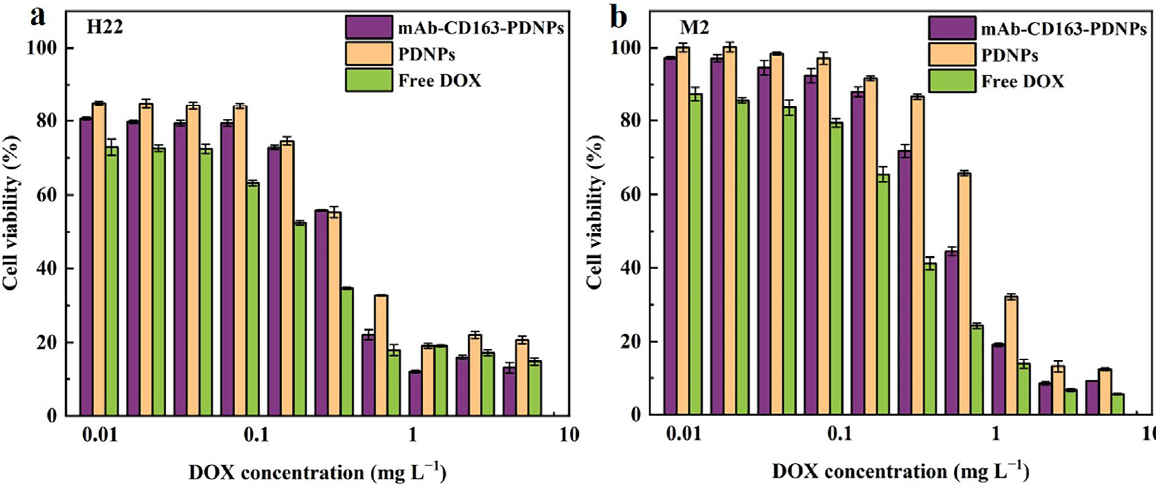
Figure 5. Cell viability of ( a ) H22 cells and ( b ) M2-type macrophages incubated with different doses of free DOX, PDNPs, and mAb-CD163-PDNPs, respectively, for 48 h. Compared with the IC 50 value of mAb-CD163-PDNPs (0.541 mg · L − 1 ) and PDNPs (0.860 mg · L − 1 ) on M2-type macrophages, it was not difficult to find that mAb-CD163- PDNPs have a stronger inhibitory effect on M2-type macrophages, which is due to the overexpression of CD163 receptors on the surface of M2-type macrophages, and